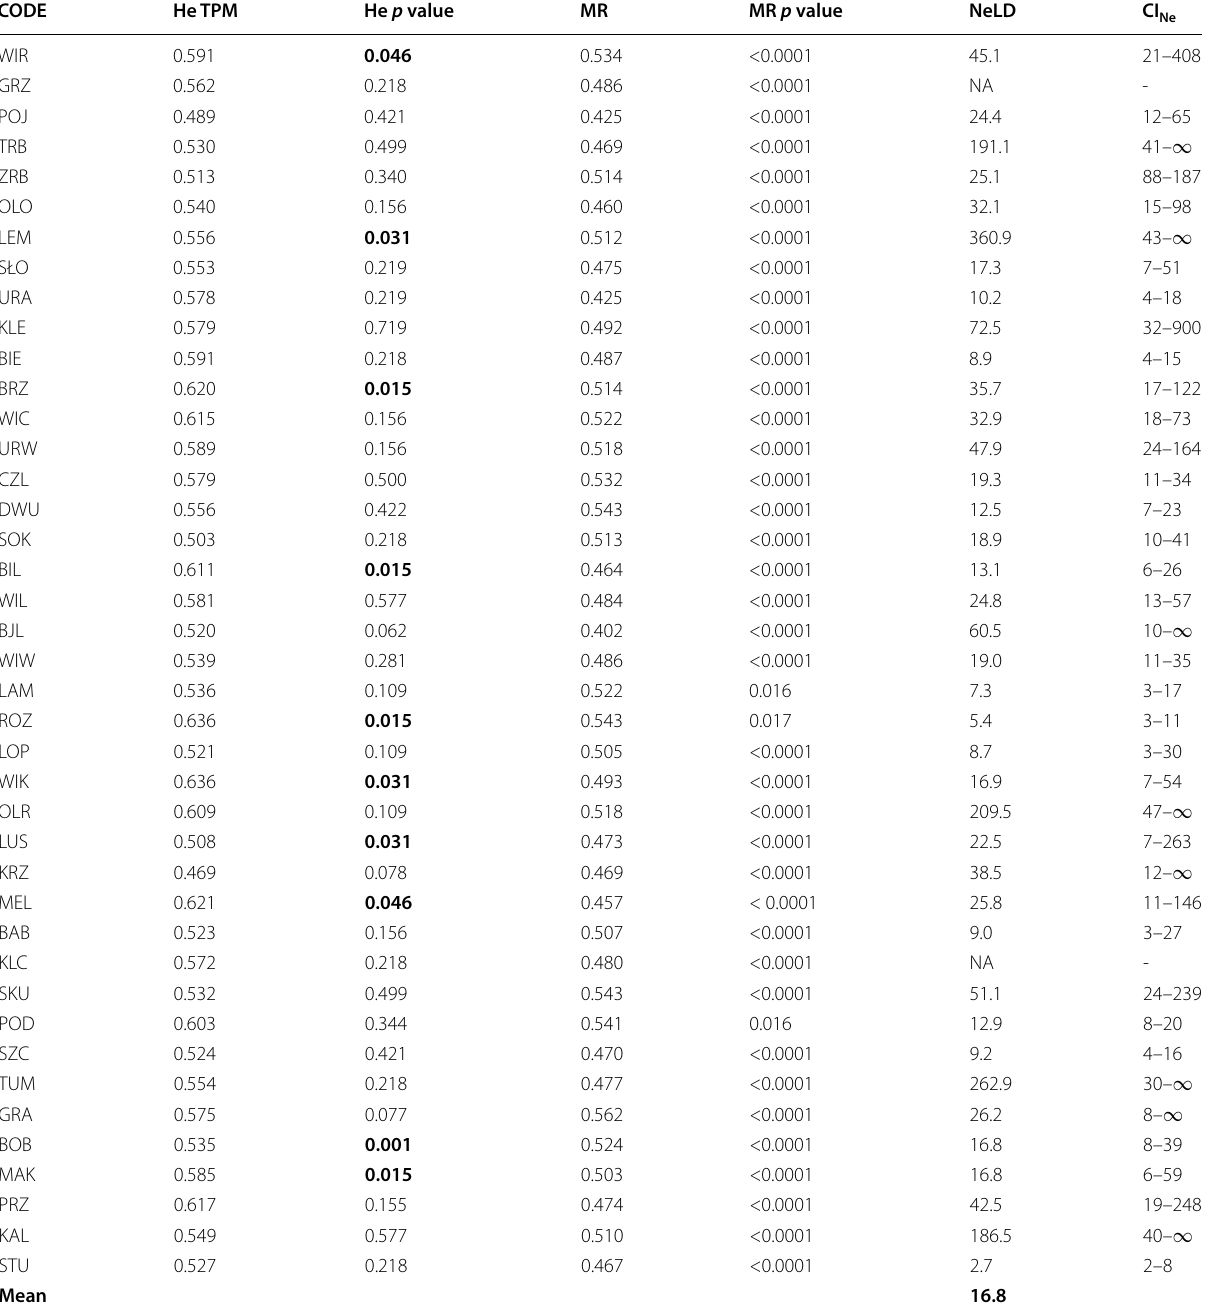
Table 3 Genetic bottleneck and estimates of the effective population sizes of U. leavis . He TPM the excess heterozygosity determined using the TPM mutation model; MR the M-ratio, He and MR p values, the p values were obtained using Wilcoxon’s signed-rank test; NeLD the effective population size; CINe is shown at the 95% confidence interval. The population codes are listed in Table